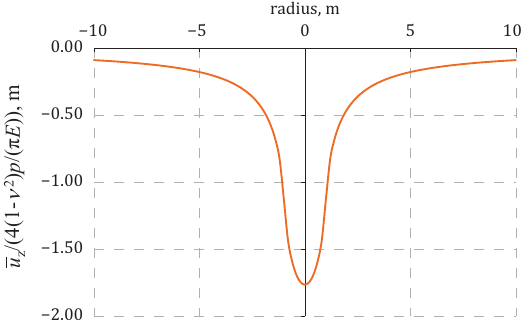
Figure 8. Demonstration of the displacement induced by the uniform